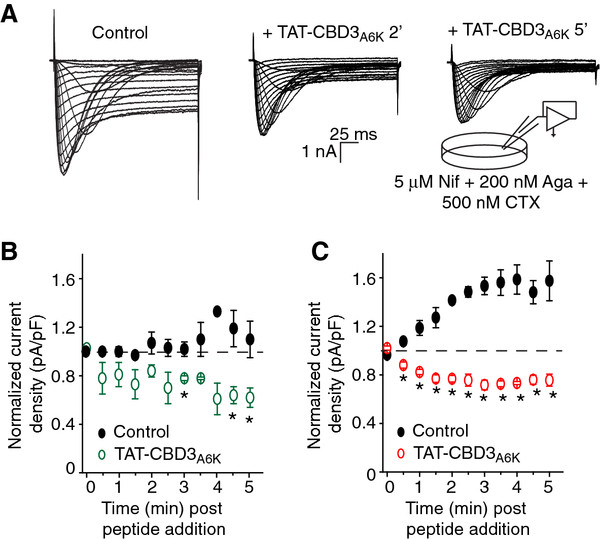
Characterization of TAT-CBD3A6K-mediated inhibition of T- and R-type calcium currents. (A) Representative family of traces from a DRG neuron with both T- and R-type calcium currents before (left), 2 min (middle) and 5 min (right) after addition of 10 μM TAT-CBD3A6K. Currents were elicited in response to the voltage protocol described in the legend to Figure 5A. To isolate T- and R-type calcium currents, the extracellular bath solution contained 5 mM Nifedipine (Nif), 200 nM ω-Agatoxin IVA (Aga) and 500 nM ω-Conotoxin GVIA (CTX) to block L-, P/Q-, and N-type calcium currents, respectively. (B, C) Time course of TAT-CBD3A6K mediated inhibition (“run-down”) of T-type (B) and R-type (C) calcium currents. Time course of inhibition is shown as averaged normalized current density (pA pF-1) before peptide addition and at intervals of 30 s for 5 min. Averaged values are shown with standard error for 4–6 control cells and 4 cells following addition of 10 μM TAT-CBD3A6K. The asterisk denotes statistical significance (p < 0.05; Student’s t-test) compared to the corresponding control time point. Some error bars are smaller than the symbols. Data represent mean ± SEM from n = 3–6 cells at each time point except for n = 2 the 4 min time point for T-type currents in the presence of peptide